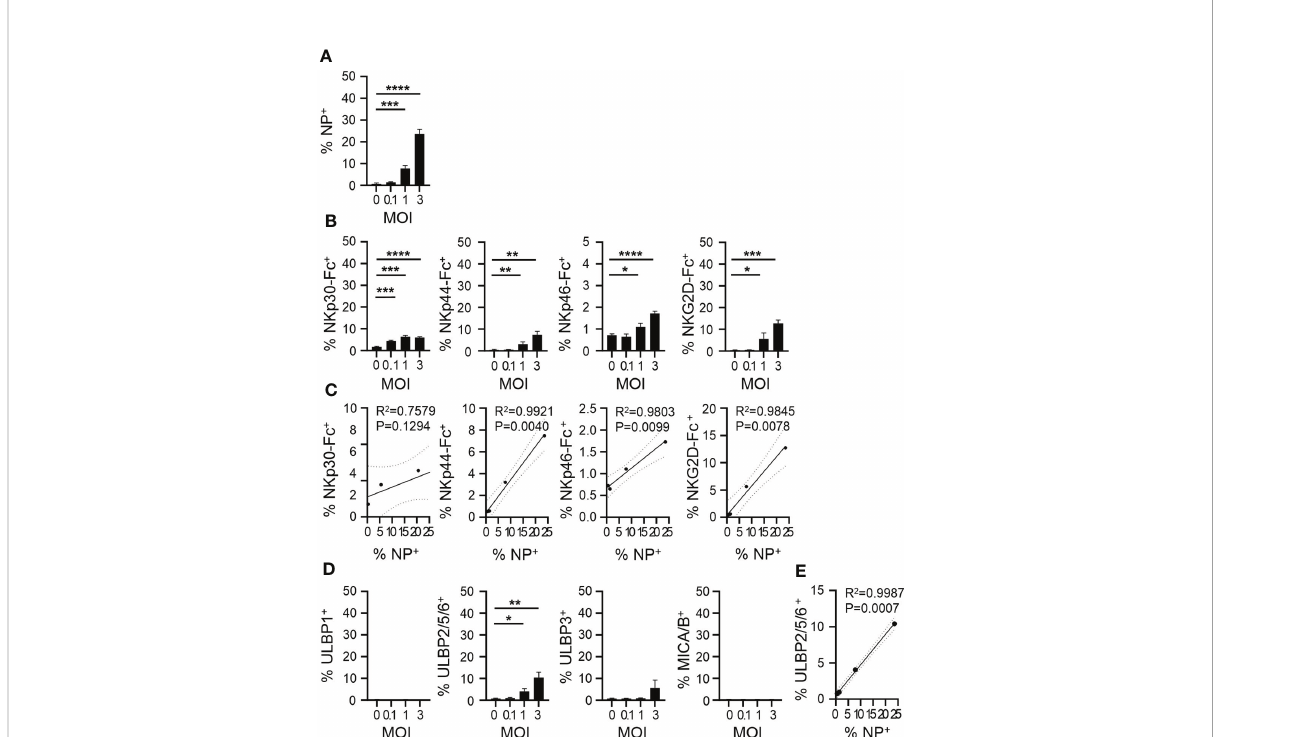
FIGURE 2 IAV upregulates NK cell ligand expression on infected cells. A549 cells were infected with in fl uenza A virus strain A/Puerto Rico/8/34 (PR8) at MOI = 0, 0.1, 1 and 3 and cells were analyzed 24h post infection using fl ow cytometry. Expression of (A) intracellular viral nucleoprotein (NP) and (B) ligands of indicated NK cell activating receptors. (C) Linear regression analysis for the level of infection (x-axis: % NP + ) and the level of NK receptor binding (y-axis). (D) Expression of indicated ligands of NKG2D. (E) Linear regression analysis for the level of infection (x-axis: % NP + ) and the level of anti-ULBP2/5/6 binding (y-axis). mean ± SD (n ≥ 3). * indicates a statistically signi fi cant difference from IgG control in the experimental group. *P < 0.05, **P < 0.01, ***P < 0.001, ****P < 0.0001. Infected cells compared to non-infected cells (unpaired t-test). MOI, multiplicity of